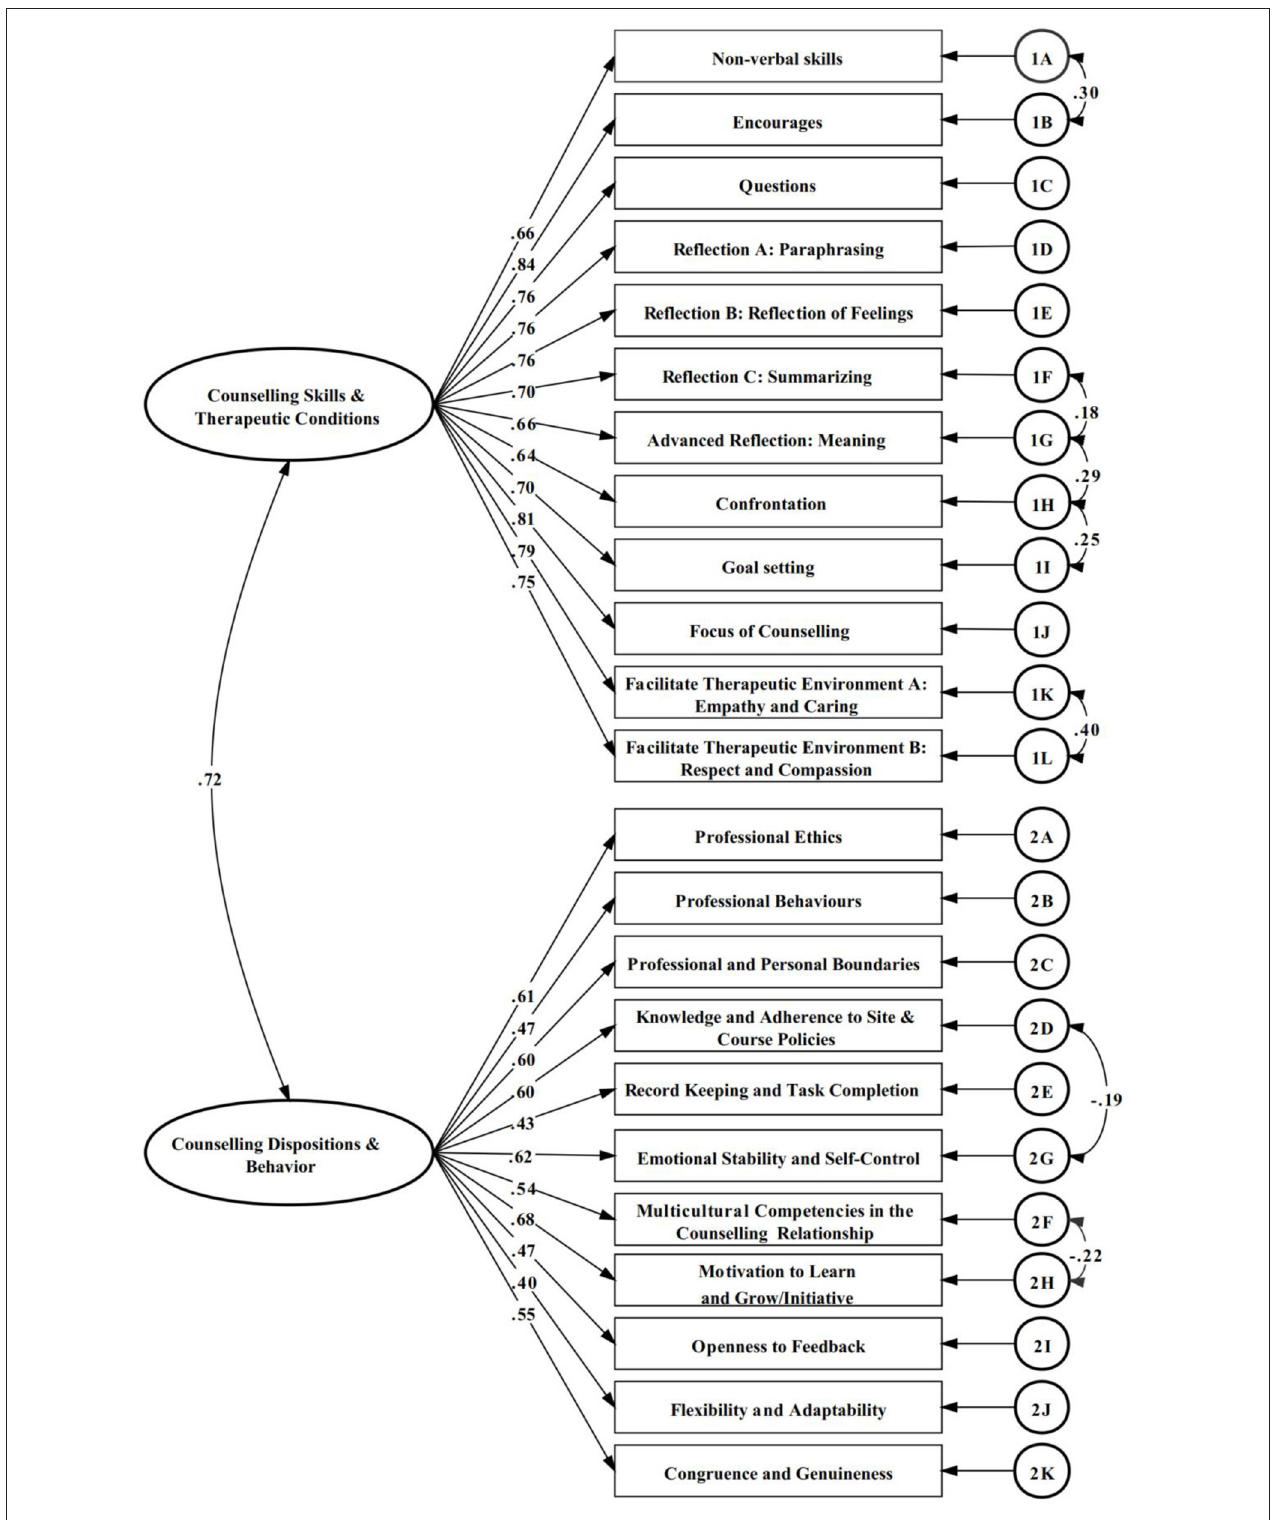
FIGURE 2 | CCS-R modified two-factor model confirmatory analysis results.